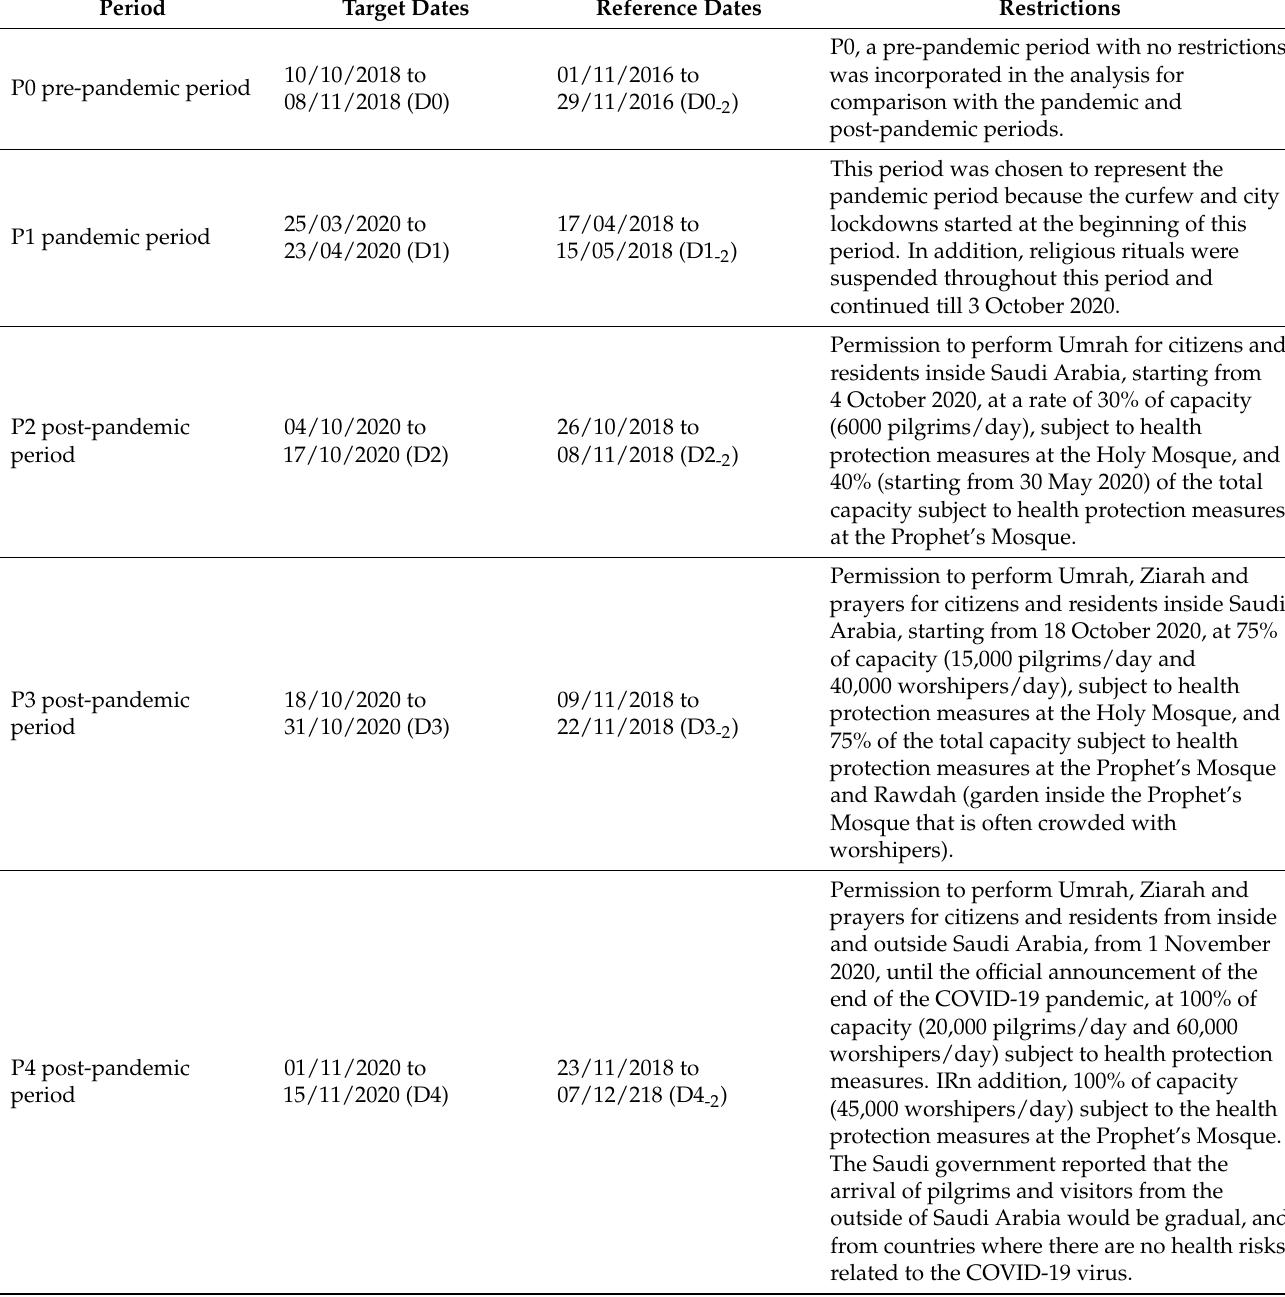
Table 1. Arrangements of the gradual resumption of the religious rituals and the different